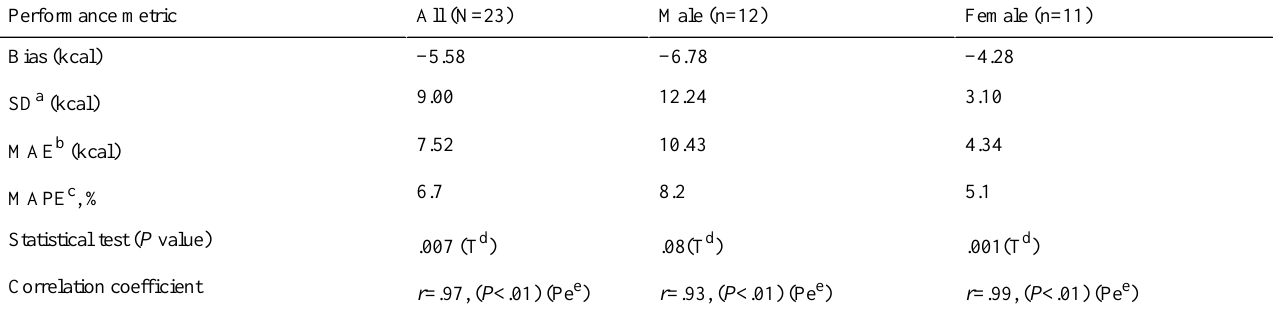
Table 6. Statistical error analysis of energy expenditure during medium heavy